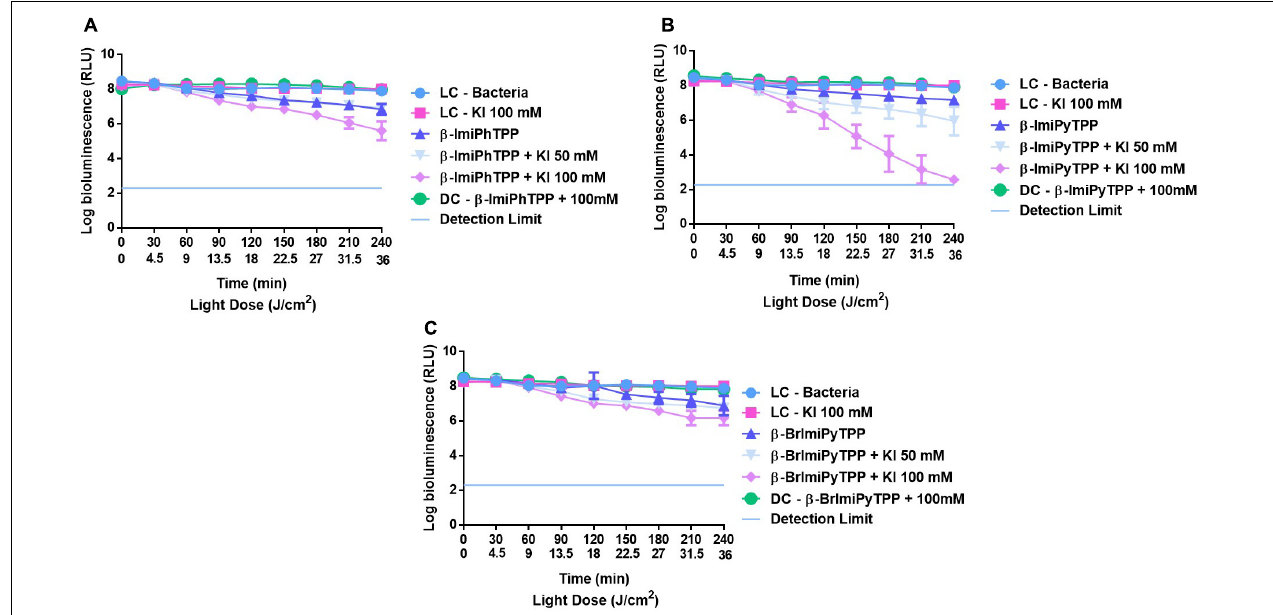
FIGURE 5 | Survival of bioluminescent E. coli during aPDT assays in the presence of mono-cationic porphyrins β -ImiPhTPP (A) , β -ImiPyTPP (B) , and β -BrImiPyTPP (C) at 5.0 µ M alone or combined with KI at 50 and 100 mM. The values are expressed as the three independent experiments; error bars indicate the